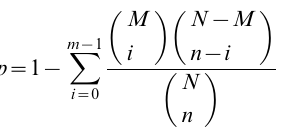
Figure S1 Sequence saturation analysis of each library. (TIF) Figure S2 Randomness assessment of each library. (TIF) Figure S3 Distribution of genes’ coverage in each library. (TIF) Figure S4 Scattered plot of differential expression genes in DA-treated and un-treated samples in differential time intervals. RPKM means Reads Per Kb per Million read. Table S1 Genes with more than 2-fold expression changes between the DA-treated and control samples are annotated by using Nr database, GO database and KEGG pathway. Table S2 Details of KEGG pathway enrichment analysis of the genes with significant expression change.